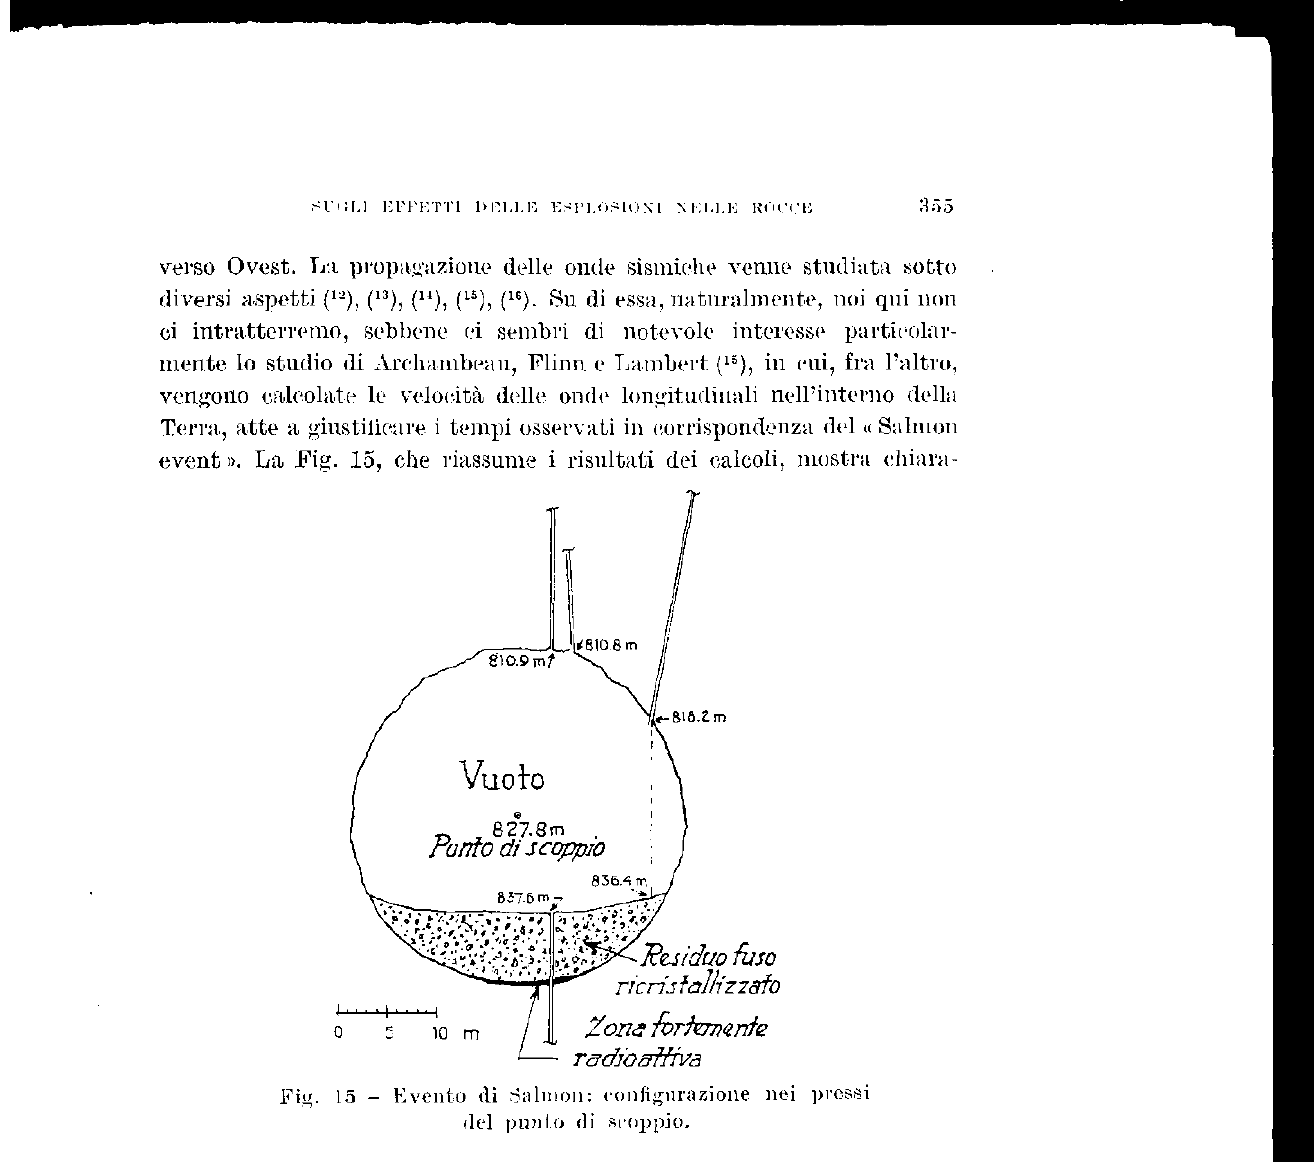
Fig. 15 - Evento di Salinoli: configurazione nei pressi del punto di